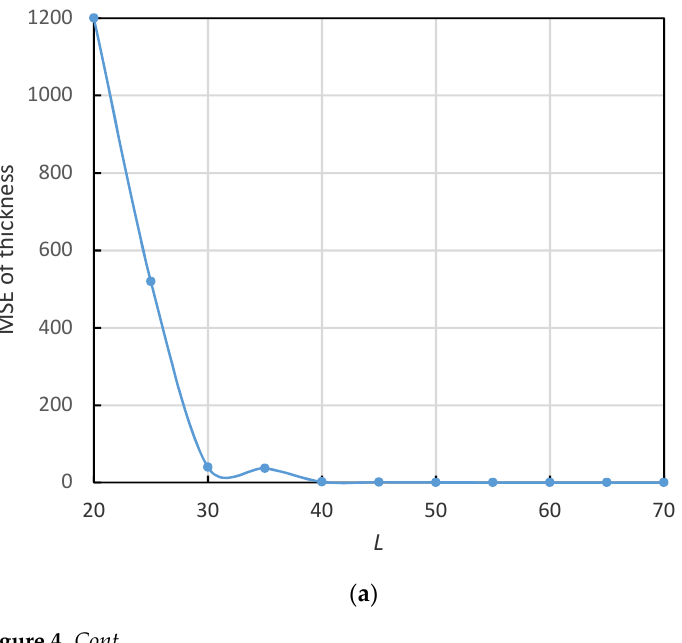
( b ) Figure 4. ( a ). The mean squared errors (MSE) of the thickness variation with L (the number of hid- den layer nodes). ( b ). The MSE of the concentrations of c 1 , c 2 variation with L (the number of hid- den nodes).